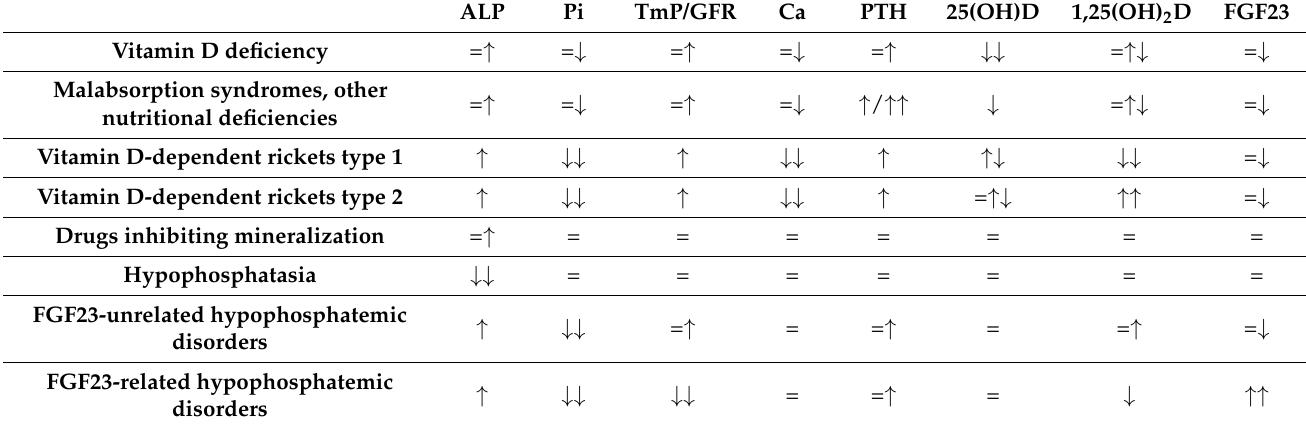
Table 2. Biochemical features (serum and urinary parameters) with differential diagnosis of the various forms of osteomalacia (=: usually in the normal range; ↓ : usually decreased; ↑ : usually increased; = ↓ : usually in the normal range or decreased; = ↑ : usually in the normal range or increased; ↓↓ : markedly decreased; ↑↑ : markedly increased; = ↑↓ : normal, increased or